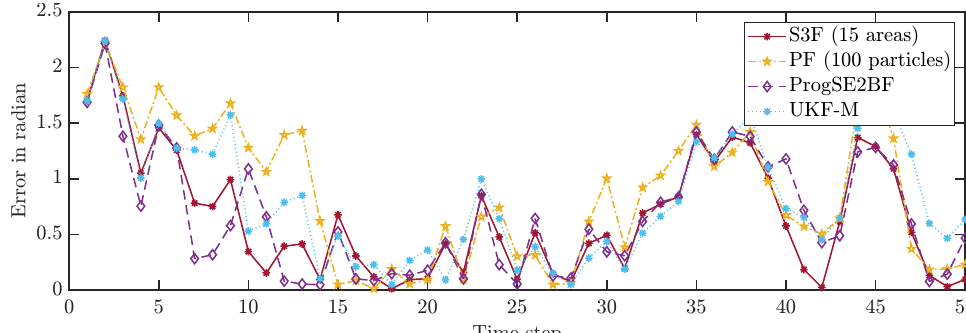
Figure 7. Orientation errors in all time steps in an example